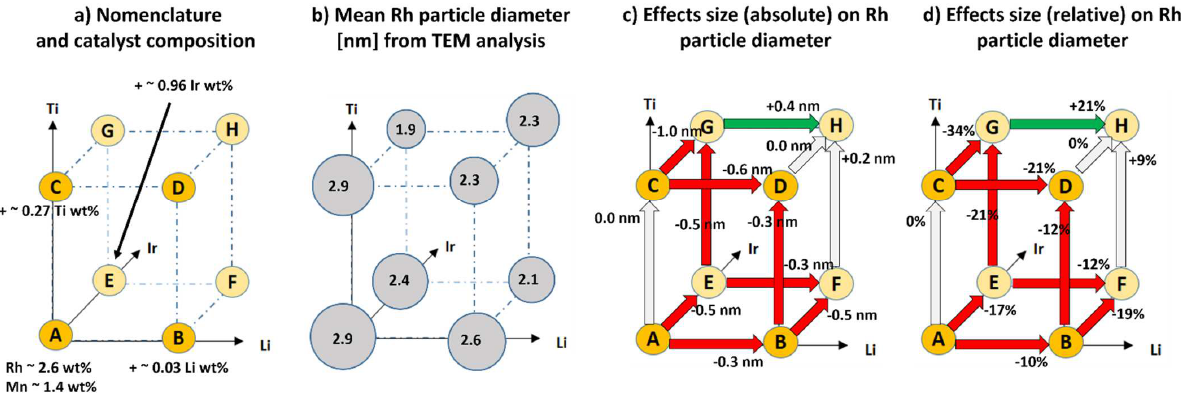
Figure 2. Representation pattern for portraying data derived for tested catalysts. ( a ) Nomenclature and composition of the catalysts studied via the cube representation, ( b ) mean Rh particle size derived from TEM analysis (cube corners), ( c ) absolute value of change shown by the arrows, ( d ) relative value of change shown by the arrows. Green arrows indicate an increase and red arrows indicate a decrease. If changes are less than the given threshold of 10%, the respective arrow is colored gray.